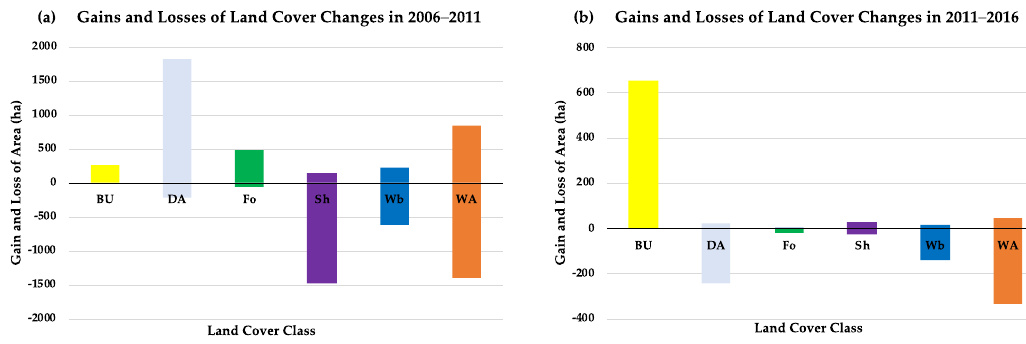
Figure 6. Land cover changes of the research site: ( a ) in 2006–2011; ( b ) in 2011–2016. Note: BU—built-up area; DA—dryland agriculture; Fo—forest; Sh—shrub; Wb—waterbody; and WA—wetland agriculture.